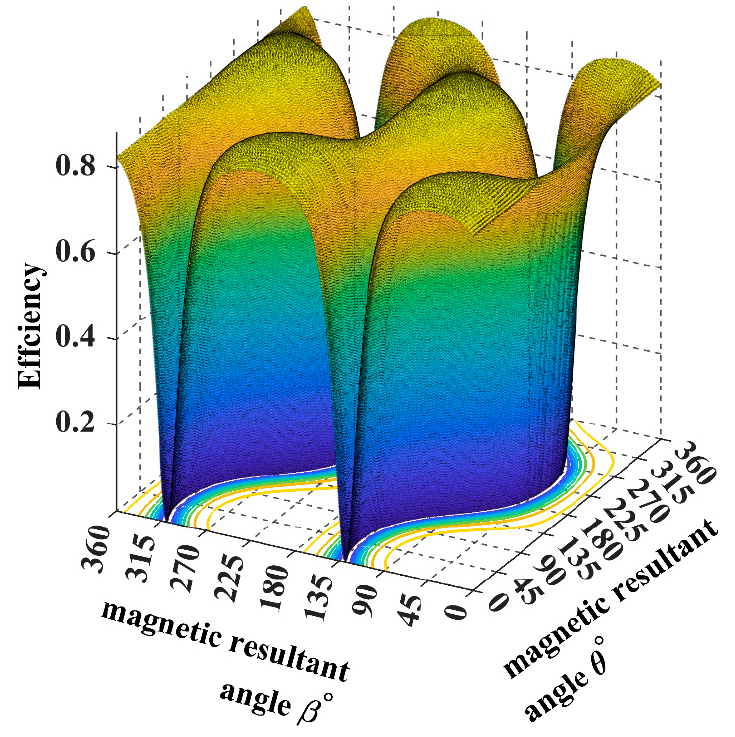
Figure 16. The system efficiency plot when the receiver is placed at 45°.